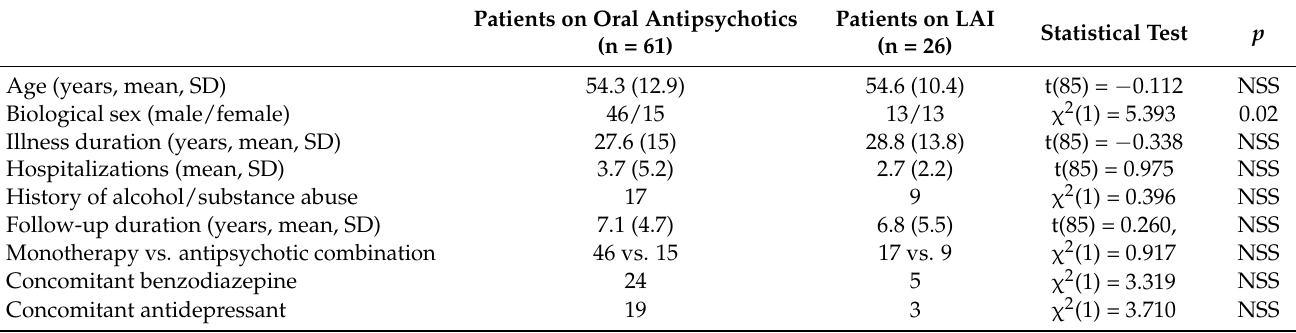
Table 3. Comparisons of patients on oral antipsychotic treatment and on LAI